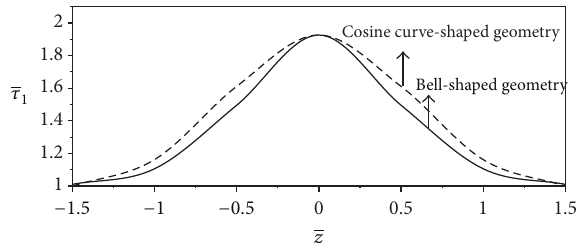
Figure 7: Variations of skin friction 𝜏 1 for Casson fluid with axial distance for different arterial